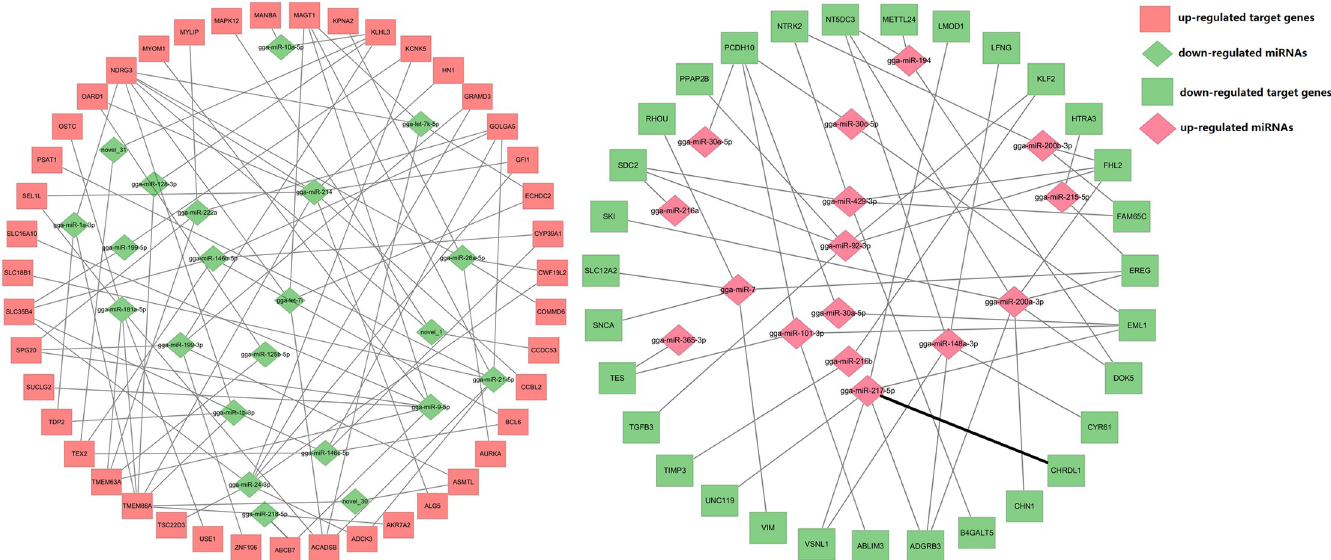
PLOS ONE | https://doi.org/10.1371/journal.pone.0237699 August 18,